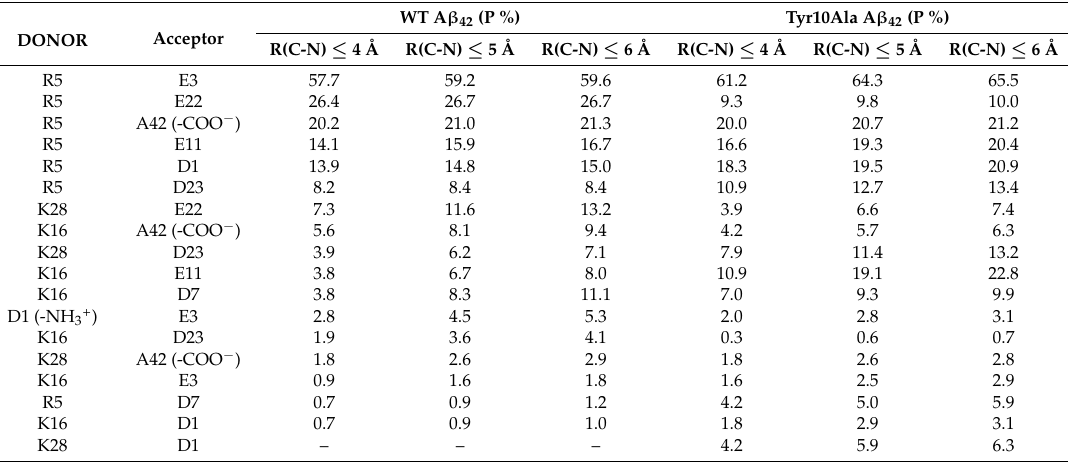
Table 3. Salt bridges formed in WT A β 42 and the Tyr10Ala mutant in aqueous